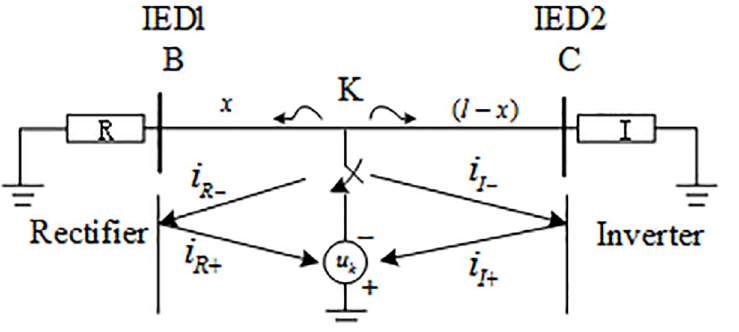
Fig 2. Internal fault additional